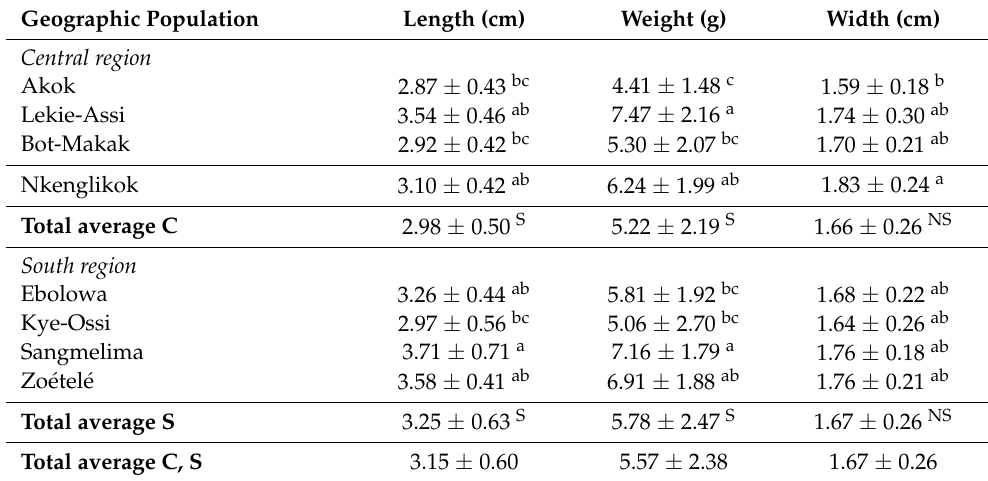
Table 3. Quantitative description of the seeds over geographic populations. Mean values and standard deviation (SD) supplemented with ANOVA (Tukey post hoc test) and t -test of statistical